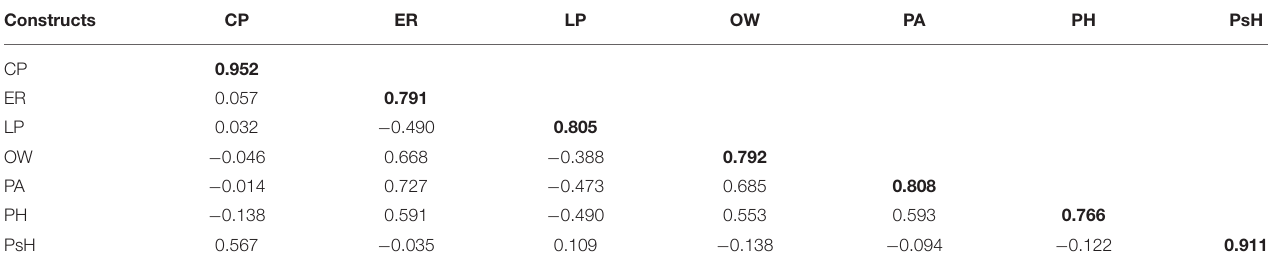
TABLE 3 | Discriminant validity: Fornell Larcker ( N = 2,200).